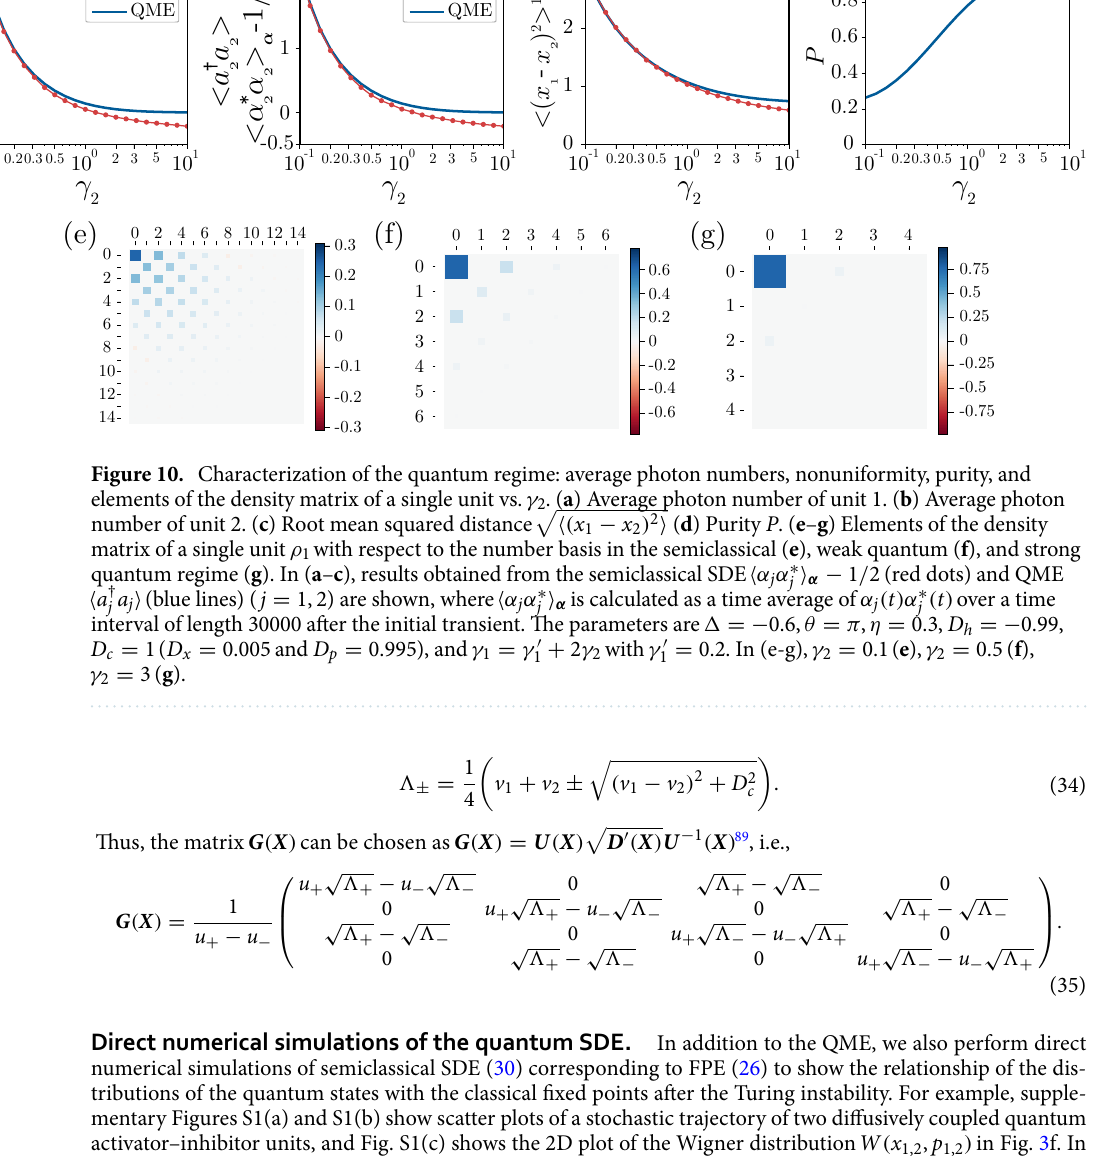
Figs. S1(a) and S1(b), the states of units 1 and 2 stochastically go back and forth between the two stable fixed points due to quantum noise. These scatter plots agree with the Wigner distributions distributed around the two stable fixed points in Fig. S1(c).